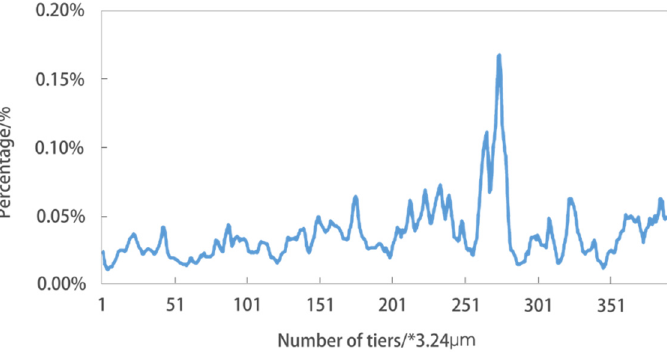
Figure 22. Diagram of volume proportion change in the voids along the direction of sample thickness.